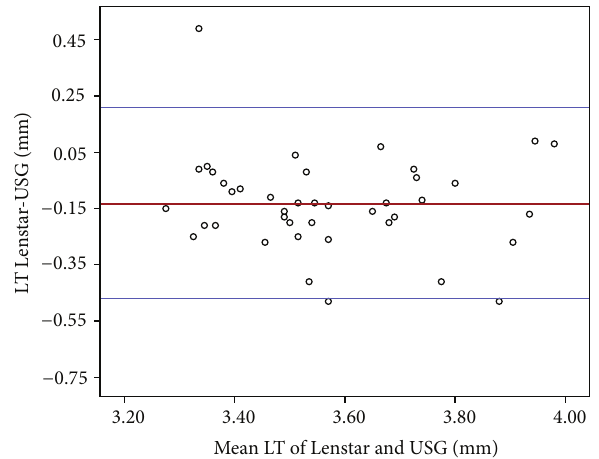
Figure 3: The Bland-Altman plot showing differences in average lens thickness (LT) measurement of the devices. The bold horizontal line demonstrates the mean difference between the devices. The dotted lines above and below represent the 95% limits of agreement interval.